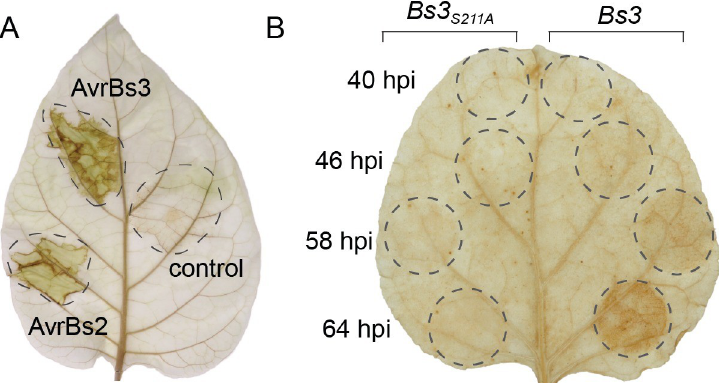
Fig 2. The Bs3-dependent HR correlates with H 2 O 2 accumulation. A) Leaves of the Capsicum annuum genotype ECW123, which contains the bacterial spot ( Bs ) R genes Bs2 and Bs3 were infiltrated with the Xanthomonas euvesicatoria strain 82–8 uns or corresponding transformants delivering the effector proteins AvrBs2 or AvrBs3. 30 hpi the inoculated leaf was stained with 3,3-diaminobenzidine tetra-hydrochloride (DAB) solution and cleared with ethanol. Dashed lines indicate inoculated leaf sections. B) 35S promoter driven Bs3-GFP and Bs3 S211A -GFP T-DNA constructs were infiltrated into N . benthamiana leaves at 0h, 6h, 18h and 24h. 64 hours after the first infiltration, the leaf was detached and vacuum infiltrated in DAB solution to visualize H 2 O 2 accumulation. Leaf was de-stained in hot ethanol. Dashed lines mark infiltrated